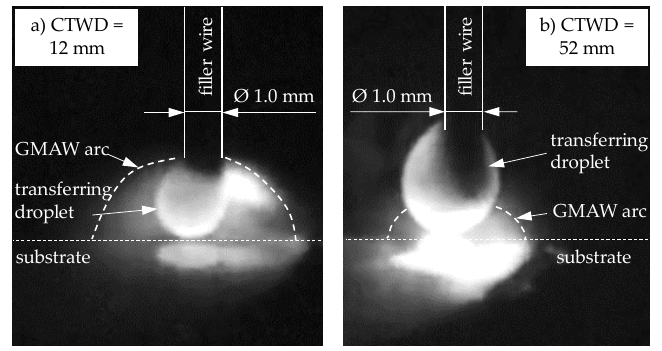
Figure 7. Correlation of droplet growth and arc behavior in GMAW with increased CTWD for U = 20 V; v wire = 5 m/min and v weld = 0.4 m/min.